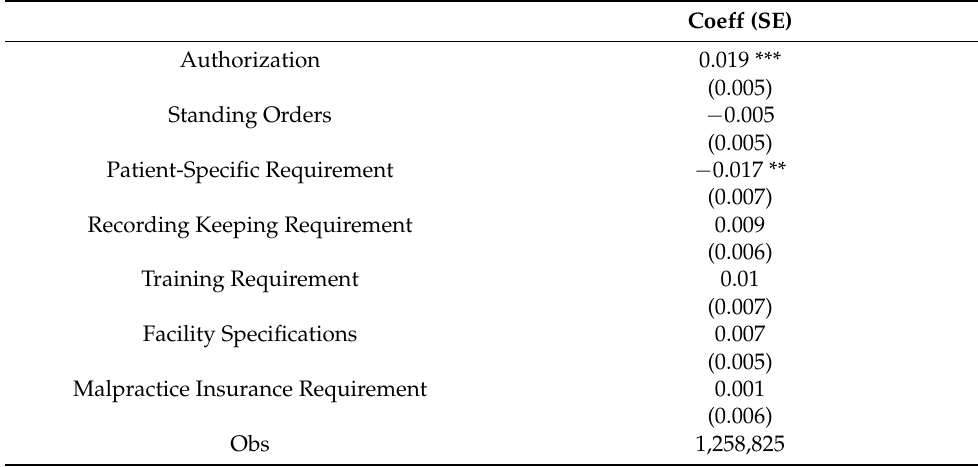
Table 4. Impacts of types of prescriptive authority and other regulations for pharmacists on influenza vaccine uptake rate,